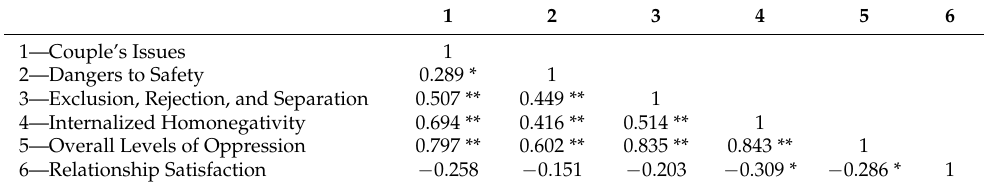
Table 6. Correlational Matrix for the Results Associating LGB Oppression and Relationship Satisfaction.